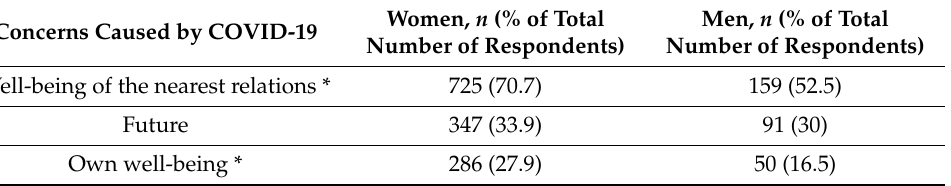
Table 8. Concerns caused by COVID-19 among women and men in the anonymously completed self-report survey in the Faroe Islands conducted from 13 April until 4 May 2020, n =